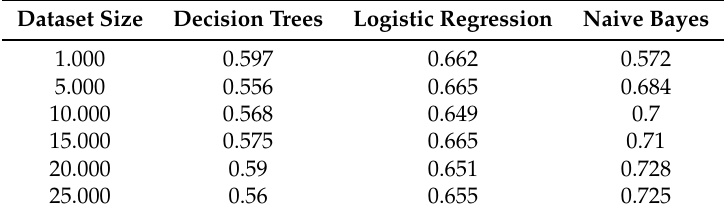
Table 9. F-Measure for Binary Classification for different dataset sizes.